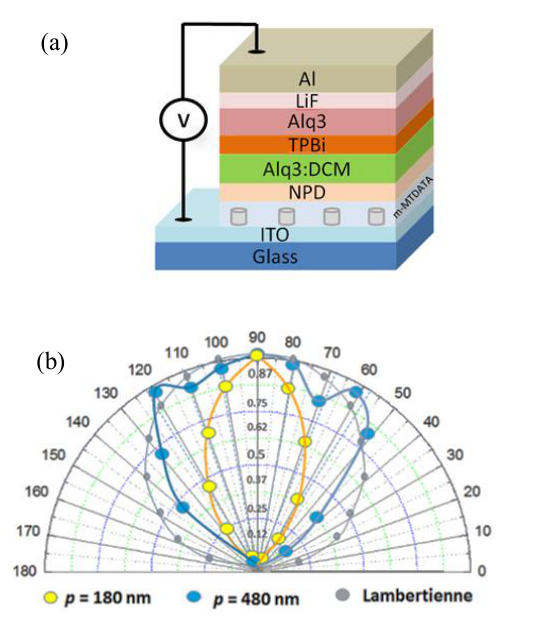
Fig. 2. (a) Scheme of the plasmonic organic light emitting diode. (b) Angular emission diagram for a conventional, plasmonic short and long period Ag-grating based